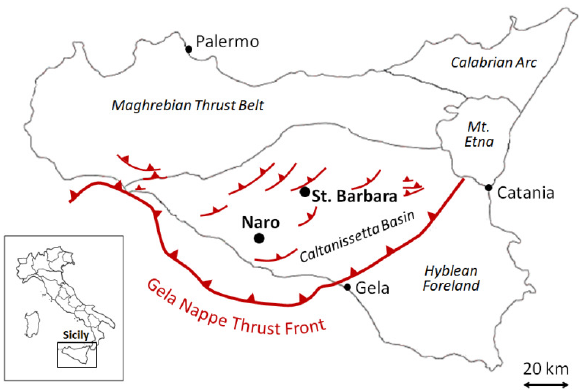
Fig. 4. Location of St. Barbara and Naro over the schematic struc- tural setting of Sicily Figure 4. Location of St. Barbara and Naro over the schematic structural setting of Sicily (Italy).626